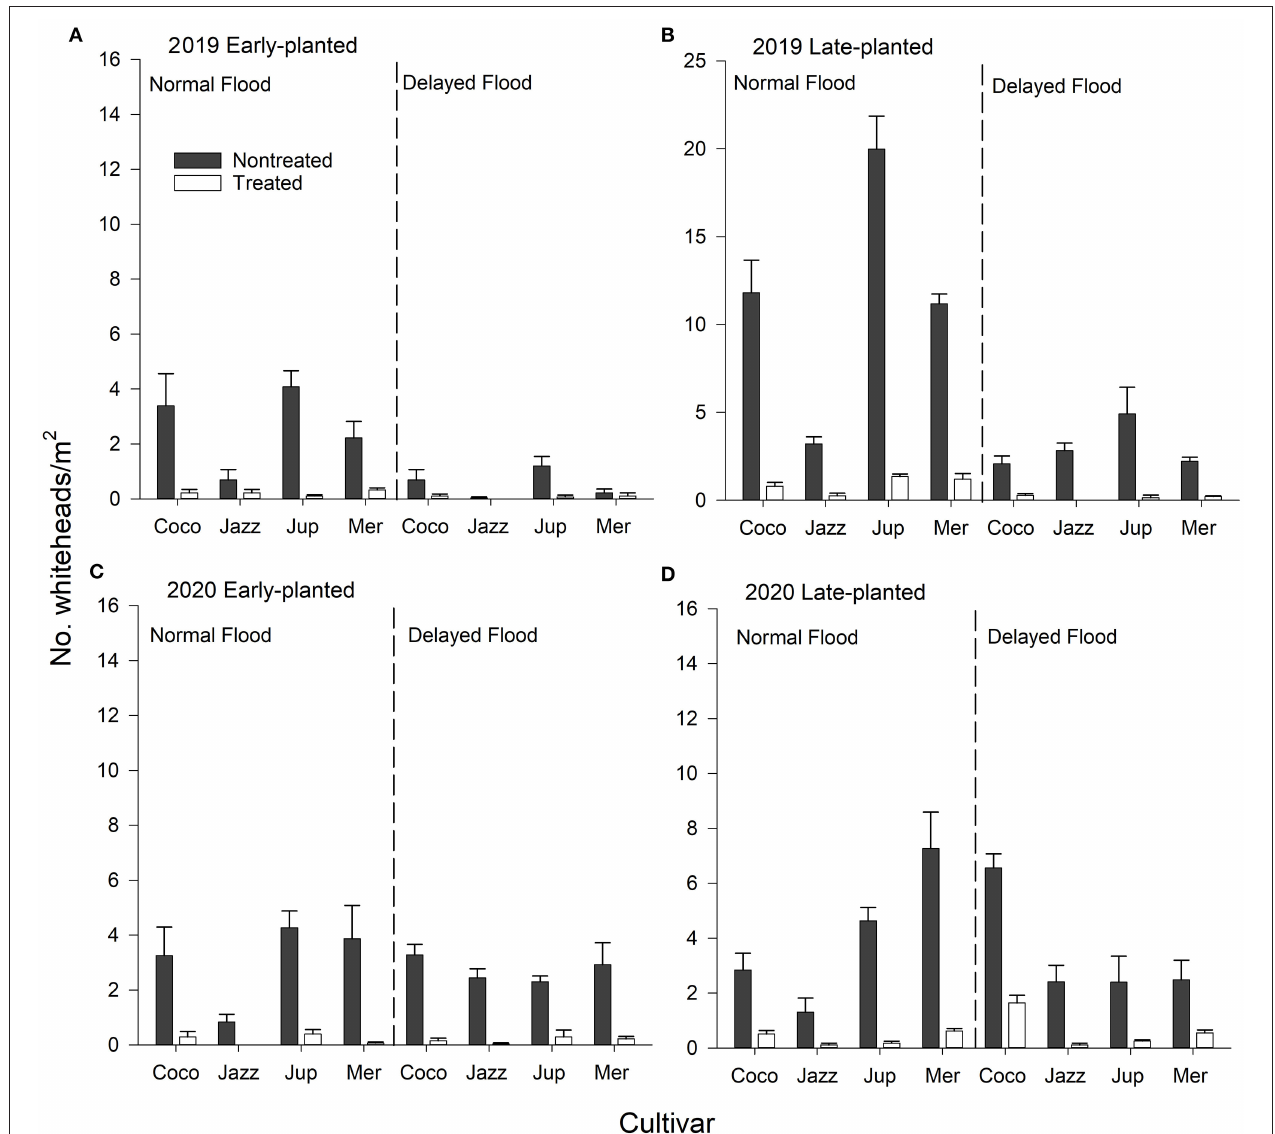
FIGURE 4 | Mean ( + SEM) whitehead (blanked panicles) densities as affected by cultivar × seed treatment × flood timing interactions, (A,B) 2019 early- and late-planted trials and (C,D) 2020 early- and late-planted trials, Crowley, Louisiana. Analyses were conducted separately by year and planting date.